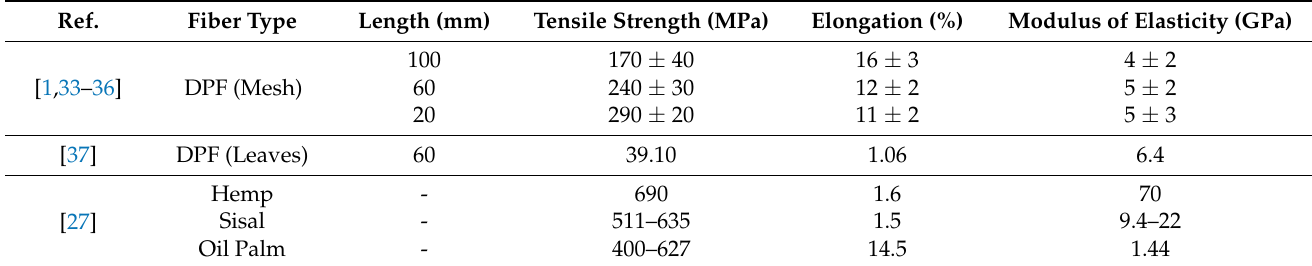
Table 2. Mechanical properties of DPF compared to other agricultural